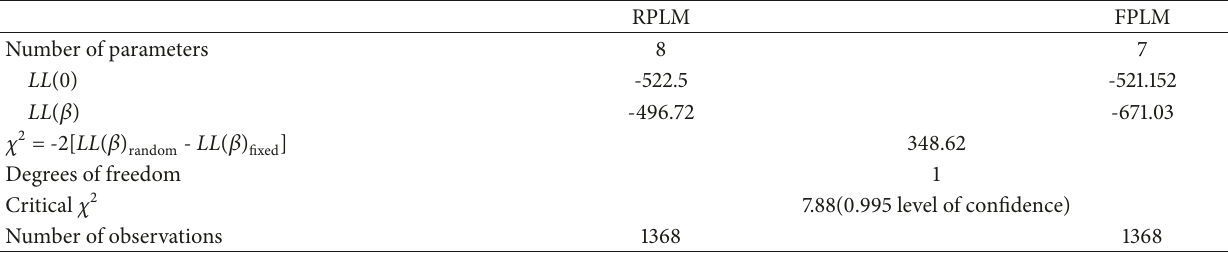
Table 5: Goodness-of-fit measures for the random and fixed parameter logit